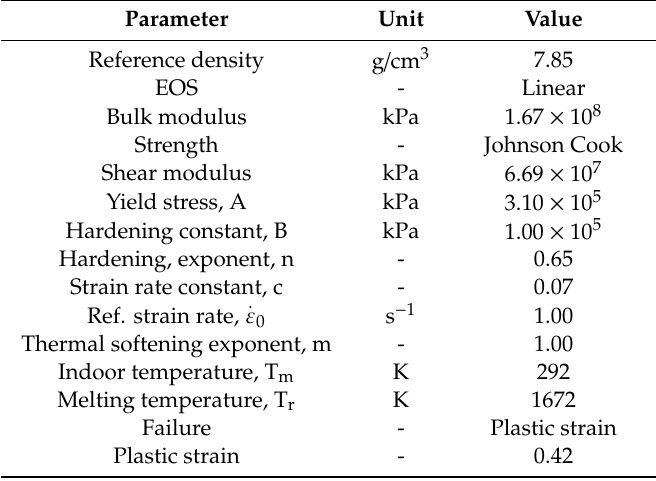
Table 4. Constitutive model of 304 stainless steel adopted in Ansys / Autodyn.